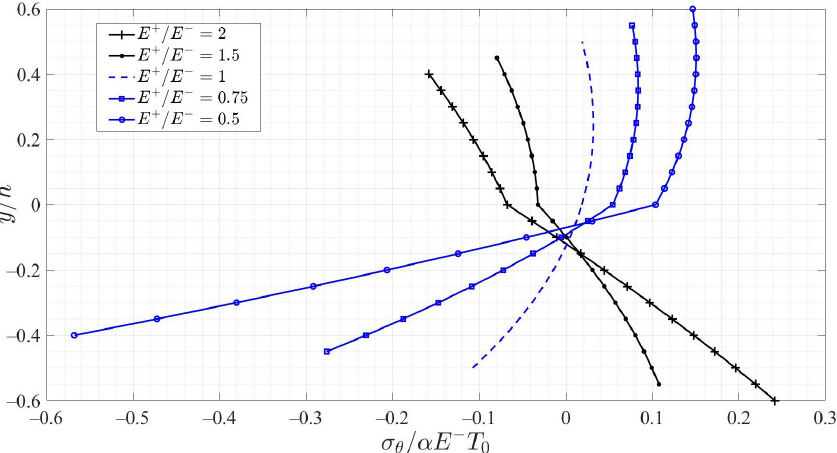
Figure 5. Thermal stress variation along thickness direction under linear temperature rise.